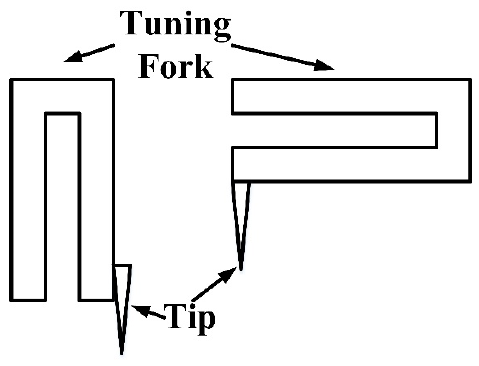
Figure 1. Normal tuning fork probes.